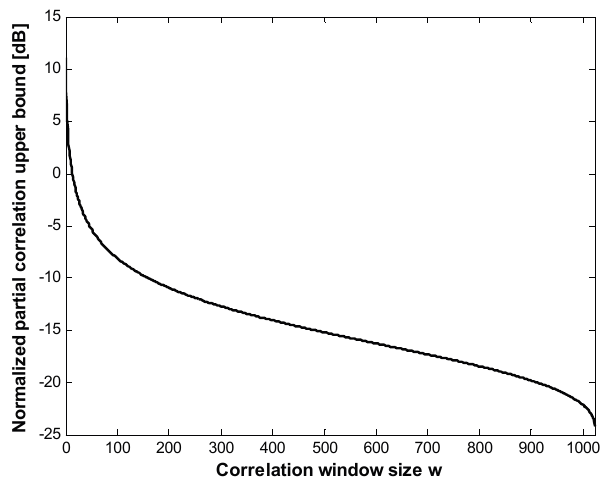
Figure 3. Cross-correlation separation of the pulsed C/A